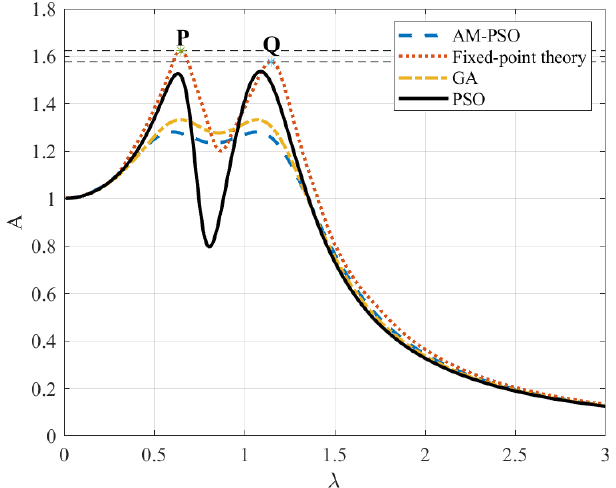
Figure 6. Comparison of the theory of Den Hartog and optimization algorithms through the frequency response curve. Table 3. Results of parameter sensitivity